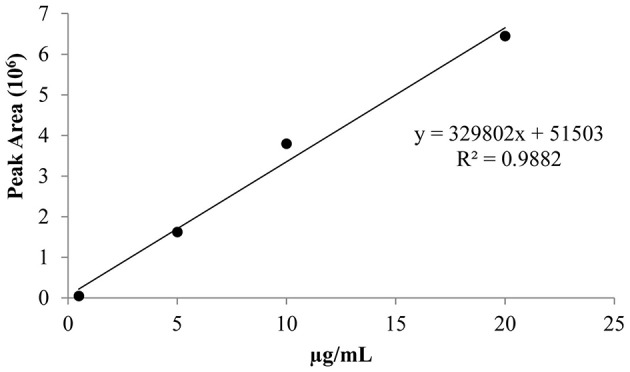
Calibration curve for ethephon analysis in the berry.